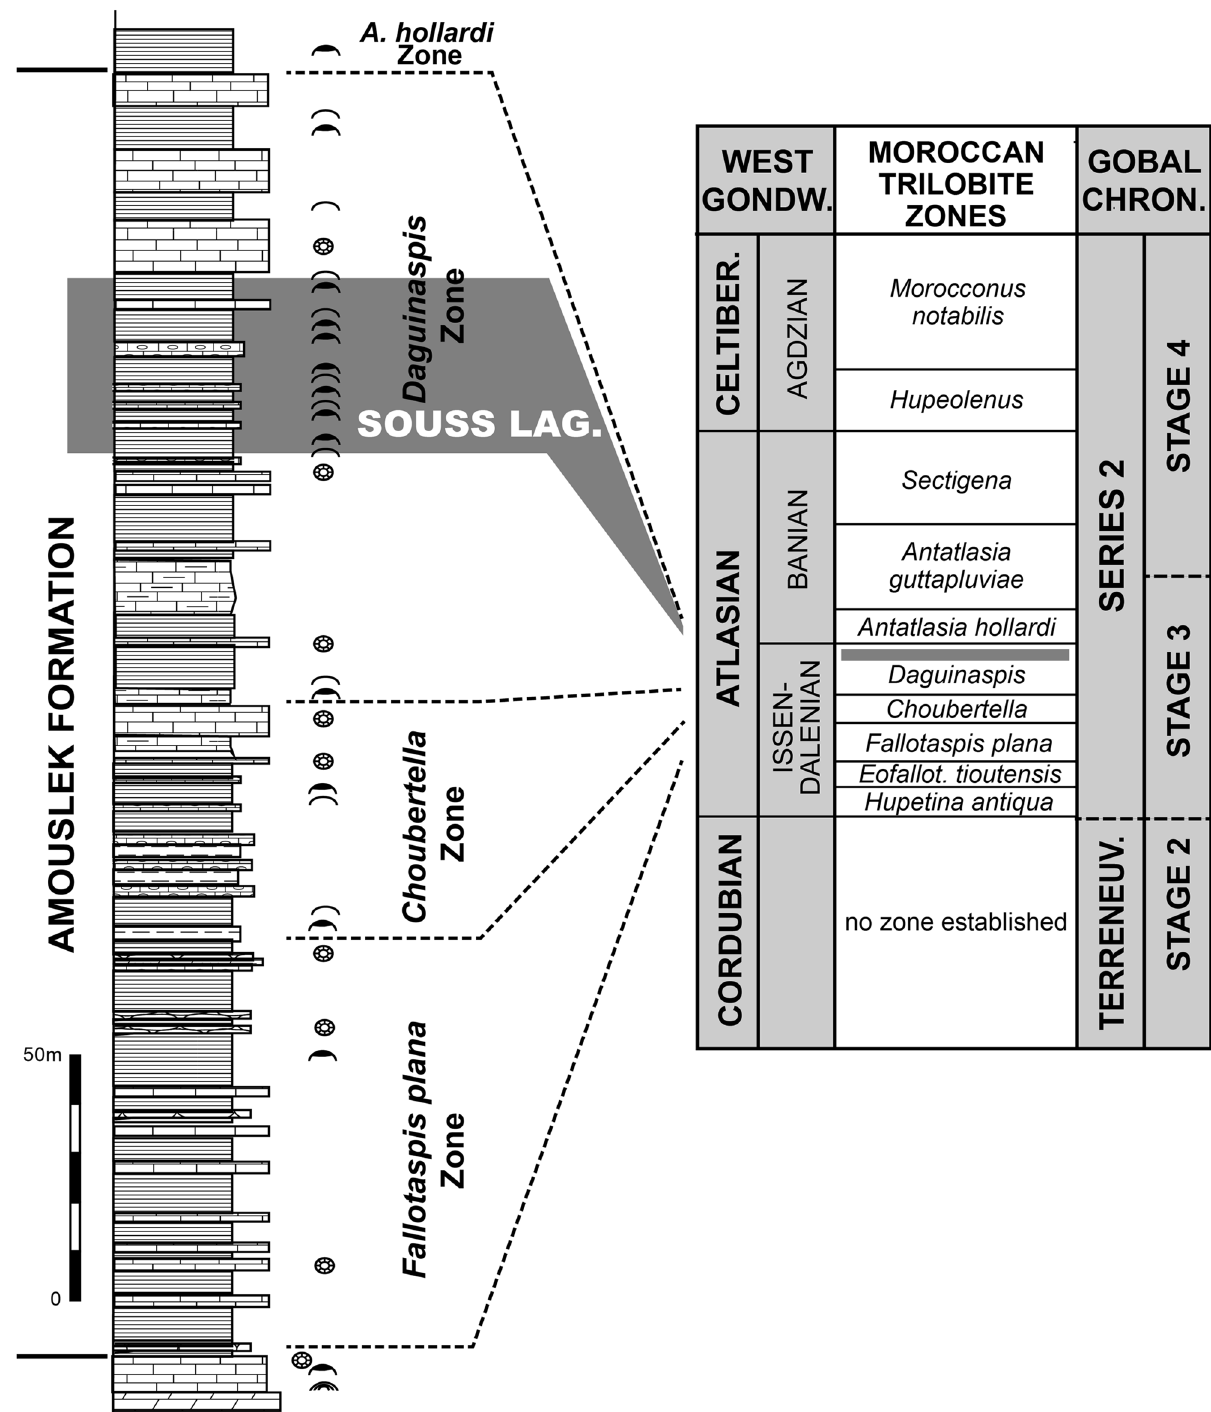
Figure 2. Stratigraphy of the Amouslek Formation at the northern slope of the western Anti-Atlas, illustrated by the Tazemmourt section (simplified, thickness of limestone beds exaggerated), with trilobite biozones, occurrences of trilobites, brachiopods and archaeocyaths and the position of the interval yielding exceptionally preserved fossils (shaded) in the early Cambrian. Abbreviations: A ., Antatlasia ; LAG,